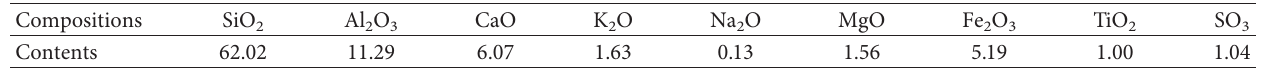
Table 2: Main chemical components of fly